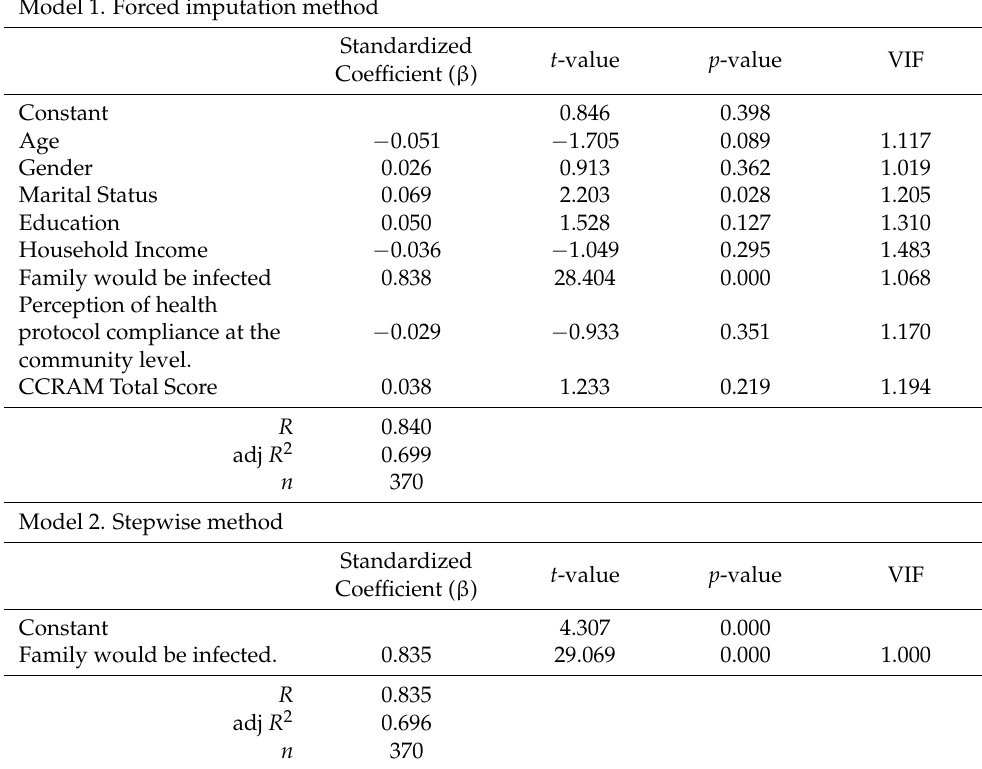
Table 3. Results of the multiple regression analyses. Note: Dependent variable for all models was “perception of the likelihood of contracting